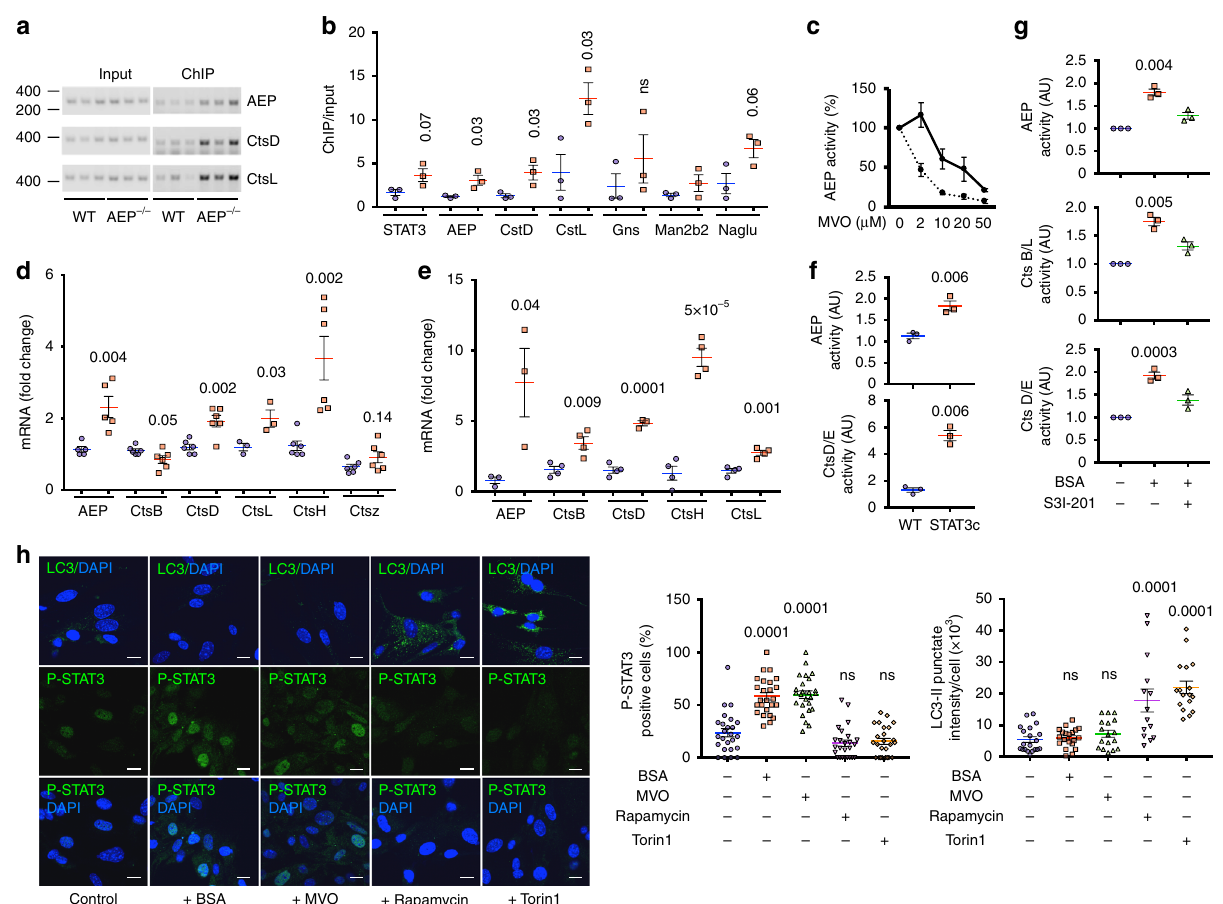
Fig. 6 Direct STAT3 involvement in regulation of lysosomal hydrolase genes under conditions of protease activity/lysosomal substrate imbalance. a Agarose gel analysis of representative ChIP-PCR products for AEP, CtsD and CtsL promoters in WT and AEP-de fi cient MEFs. Full data and gel calibration markers can be seen in Supplementary Fig. 6. b Quantitative PCR analysis of DNA from STAT3 ChIP of WT (blue circles) and AEP-de fi cient (red squares) MEFs expressed as fold enrichment. Data are the average ± SD of n = 3 biologically independent samples. Statistical signi fi cance was calculated using a two-sided unpaired t- test. c AEP activity in WT MEF treated overnight with different concentrations of MVO26630 in the presence (dashed line) or absence (solid line) of 100 μ M S3I-201. Data are the average ± SD of three independent experiments. d Quantitative PCR analysis of the mRNA levels for different lysosomal proteases in WT (blue circles) and STAT3c 3T3 (red squares) cells. Data are the average ± SD of n = 6 biologically independent samples for all samples, except for AEP where n = 5 and CtsL where n = 3. Statistical signi fi cance was calculated using a two-sided unpaired t- test. e Quantitative PCR analysis of the mRNA levels for different lysosomal proteases in WT MEFs treated (red squares) or not (blue circles) with 30 mg/ml BSA overnight. Data are the average ± SD of n = 4 biologically independent samples for all samples, except for AEP and CtsD where n = 3. Statistical signi fi cance was calculated using a two-sided unpaired t- test. f AEP and CtsD/E activities measured in WT and STAT3c 3T3 cells. Data are the average ± SD of n = 3 biologically independent samples. Statistical signi fi cance was calculated using a two-sided unpaired t -test. g Activities of AEP, CtsB/L